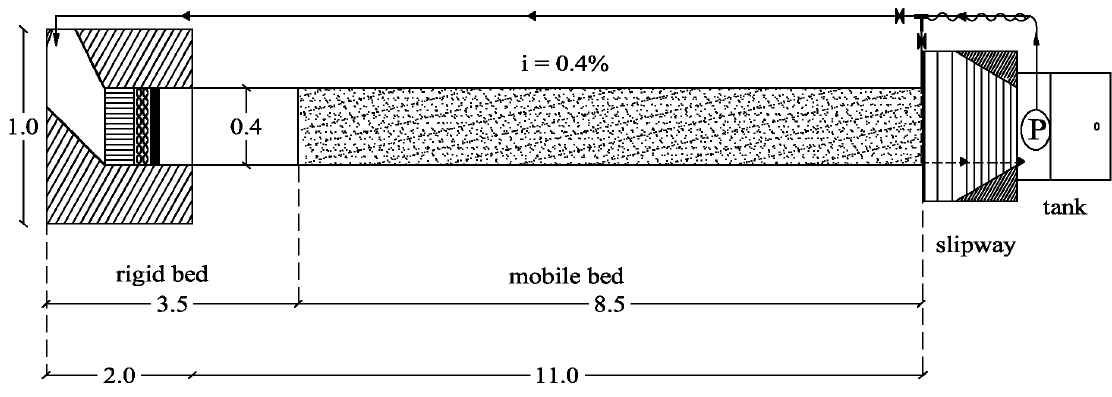
Fig. 1 Plane view of the experimental apparatus